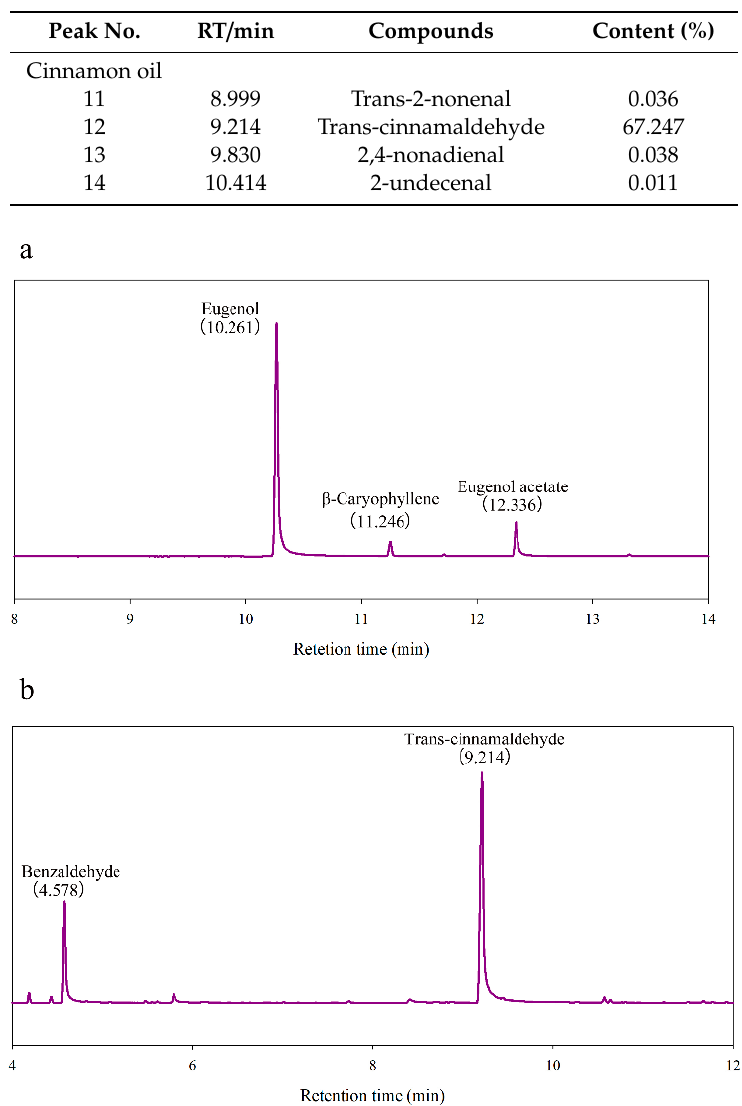
Figure 2. Chemical composition of essential oils analyzed by GC-MS: ( a ) clove oil; ( b ) cinnamon oil. Table 2. The main components of the essential oils of clove and cinnamon oil analyzed by GC–MS. Peak No.